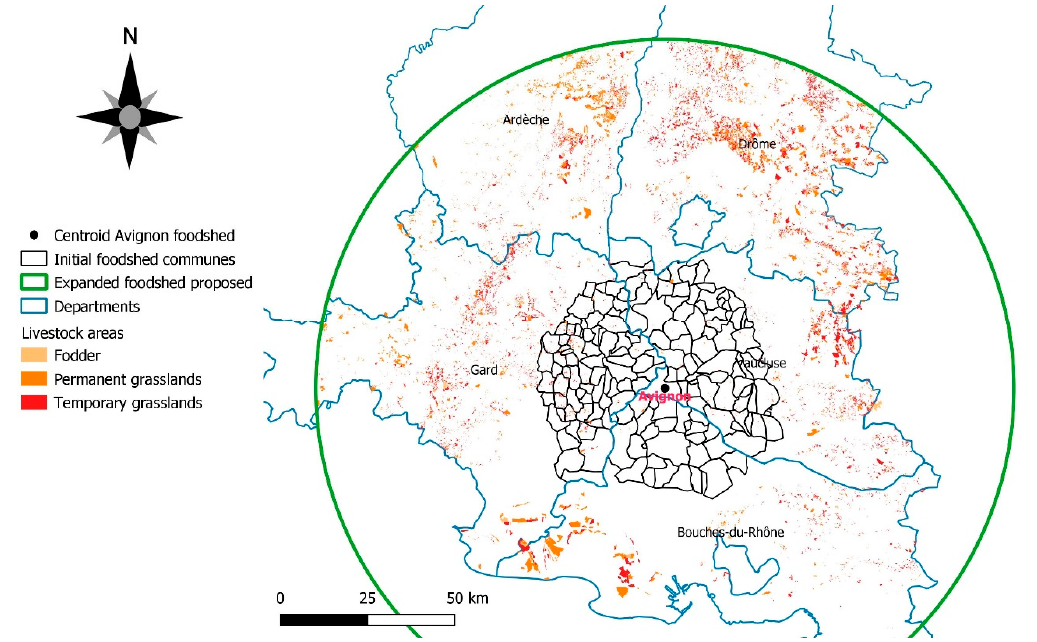
Figure 8. Current area used for livestock in the five departments considered in the study (blue) in the expanded foodshed proposed (radius of 100 km) (green bold). The areas under soils with > 80 cm depth were excluded from the assessment.